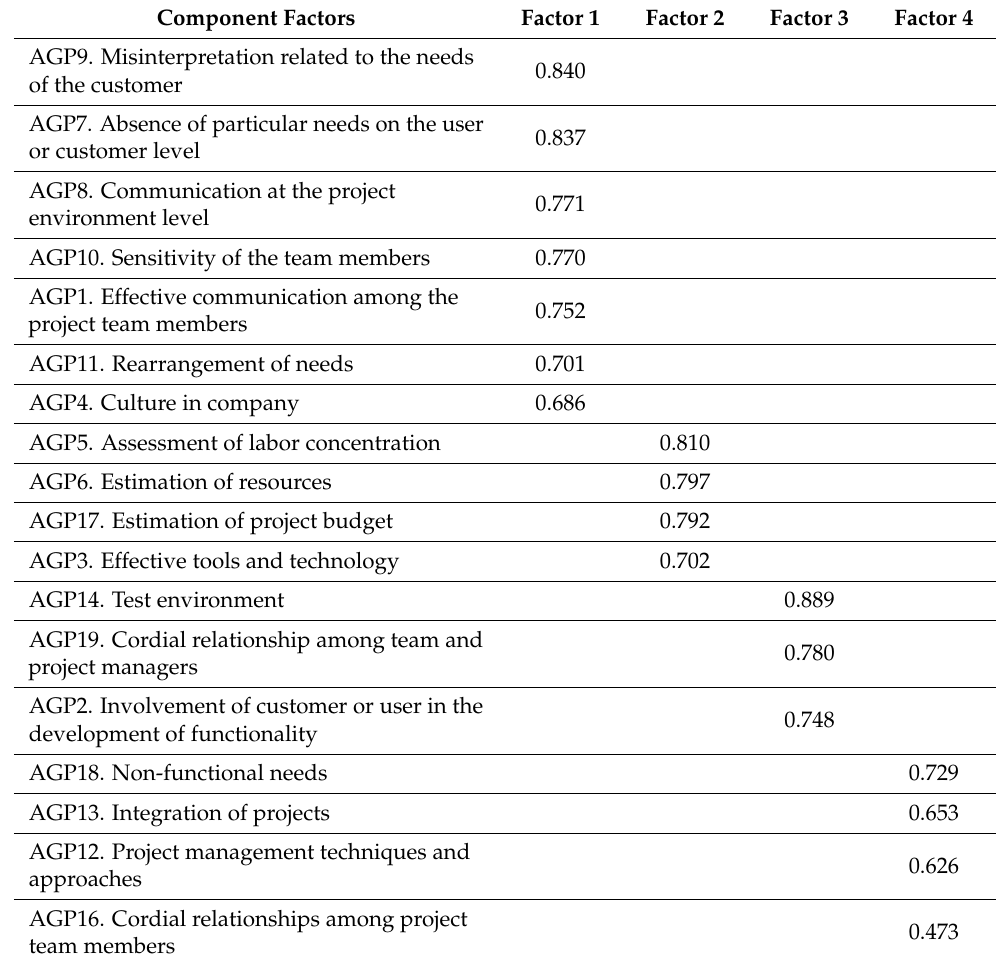
Table 5. Exploratory Factor Analysis (Rotated Component Matrix).